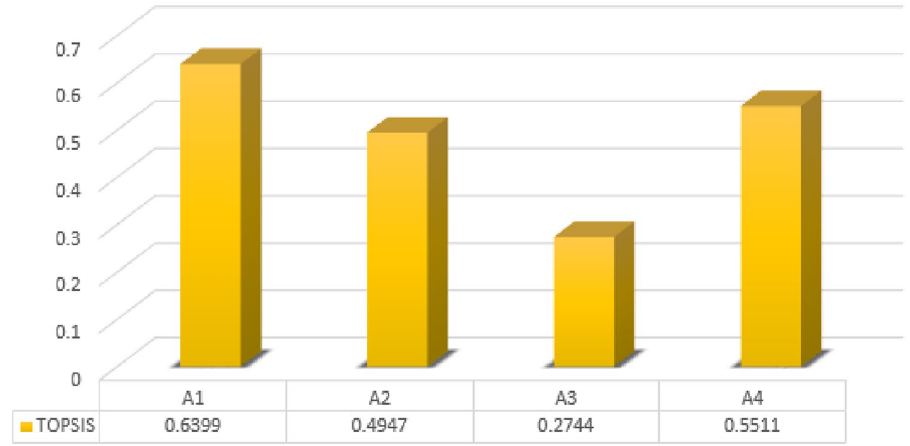
Figure 4. The schematic depiction of the ranking based on the improved TOPSIS